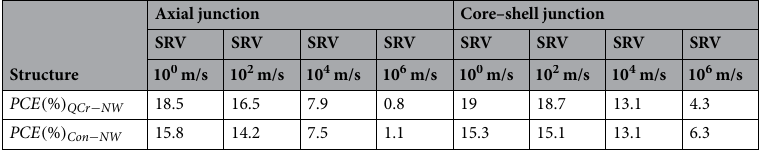
Table 7. The PCE of the proposed and conventional NW designs in the axial and core–shell junction at SRVs values.